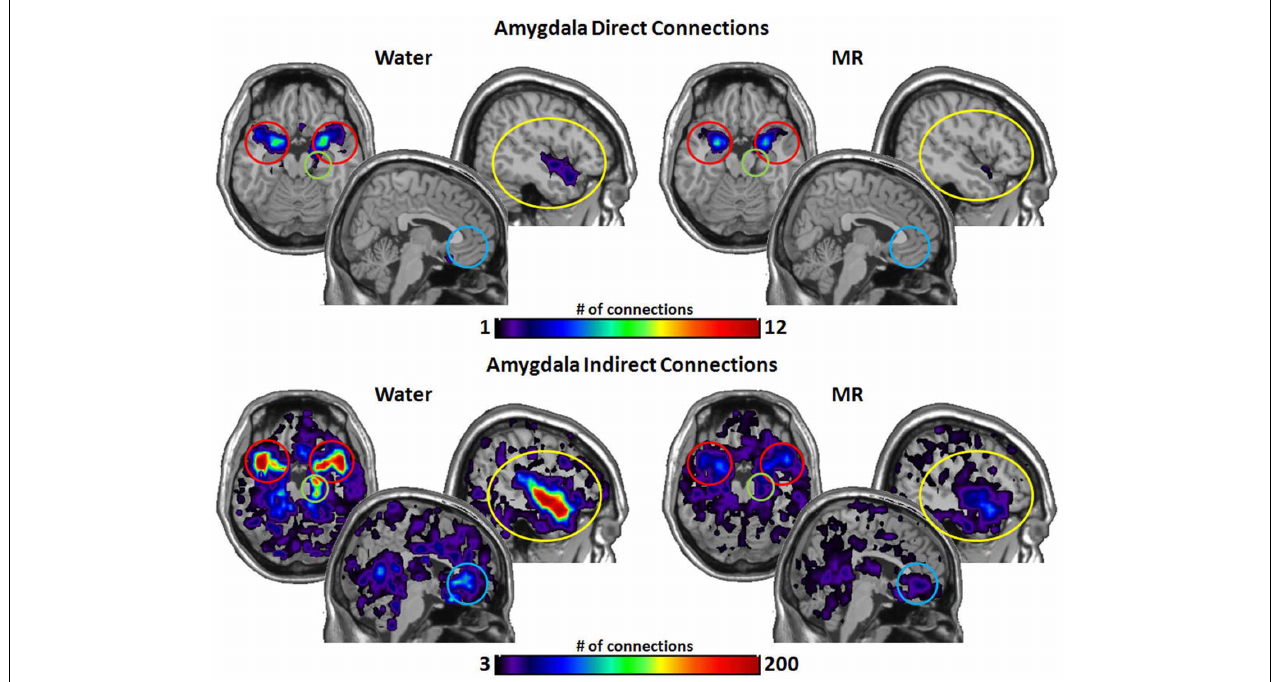
FIGURE 6 | The brain images on the top demonstrate the total number of direct connections from the amygdalae averaged across participants. Thesetopimagesdemonstratethattheamygdalahasagreaternumberofdirect connectionswiththeinsuladuringthewaterthanintheMRcondition. Thebrain images on the bottom demonstrate the total number of indirect connections